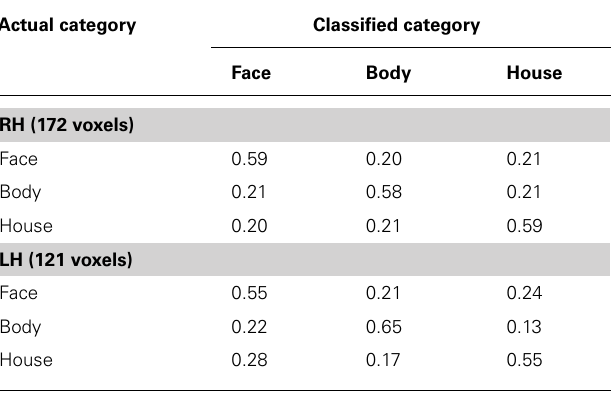
Values represent average fraction (across participants) of face, body, and house blocks each classified as face, body, or house blocks. An ideal confusion matrix (i.e., perfectclassification)wouldhavevaluesof1onthediagonal(grayedentries) and values of 0 on the off-diagonal entries (errors). RH, right hemisphere; LH, left